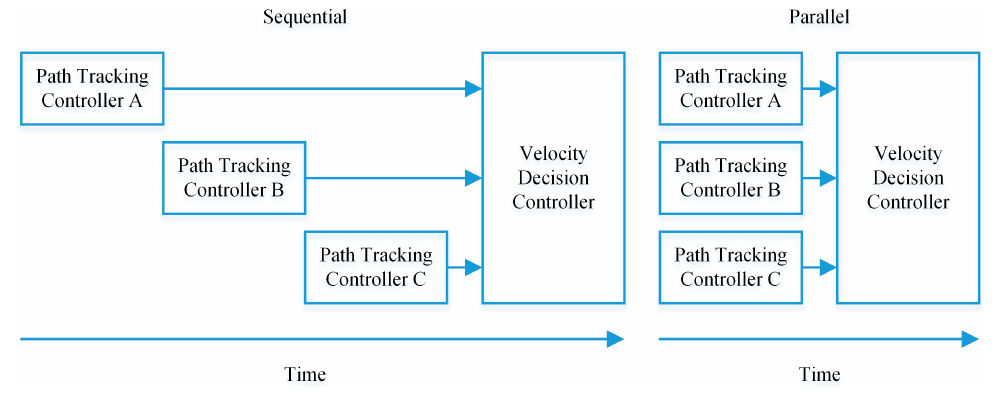
Figure 11. Two calculation processes of multilayer MPC.